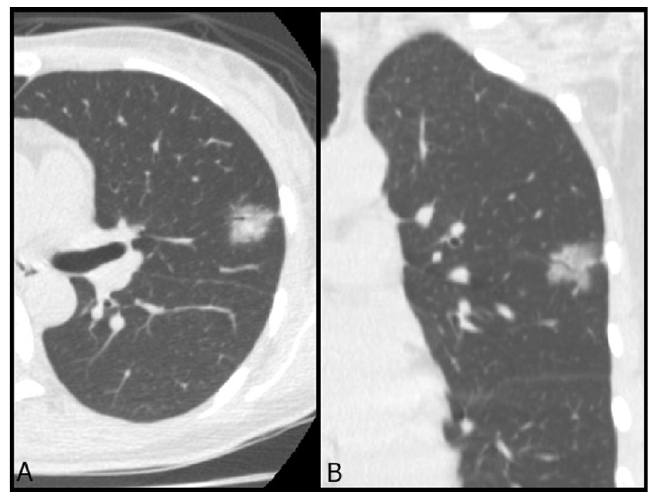
Figure 3. A typical example case of subsolid nodule with an air bronchogram sign in LUL. A 61-year-old woman had a 1.4 cm part-solid nodule in LUL. The ( A ) axial and ( B ) coronal images showed an internal air bronchogram inside the lesion. The patient underwent video-thoracoscopic wedge resection of LUL. Further pathologic report demonstrated invasive pulmonary adenocarcinoma in LUL, Stage T1bN0M0. LUL left upper